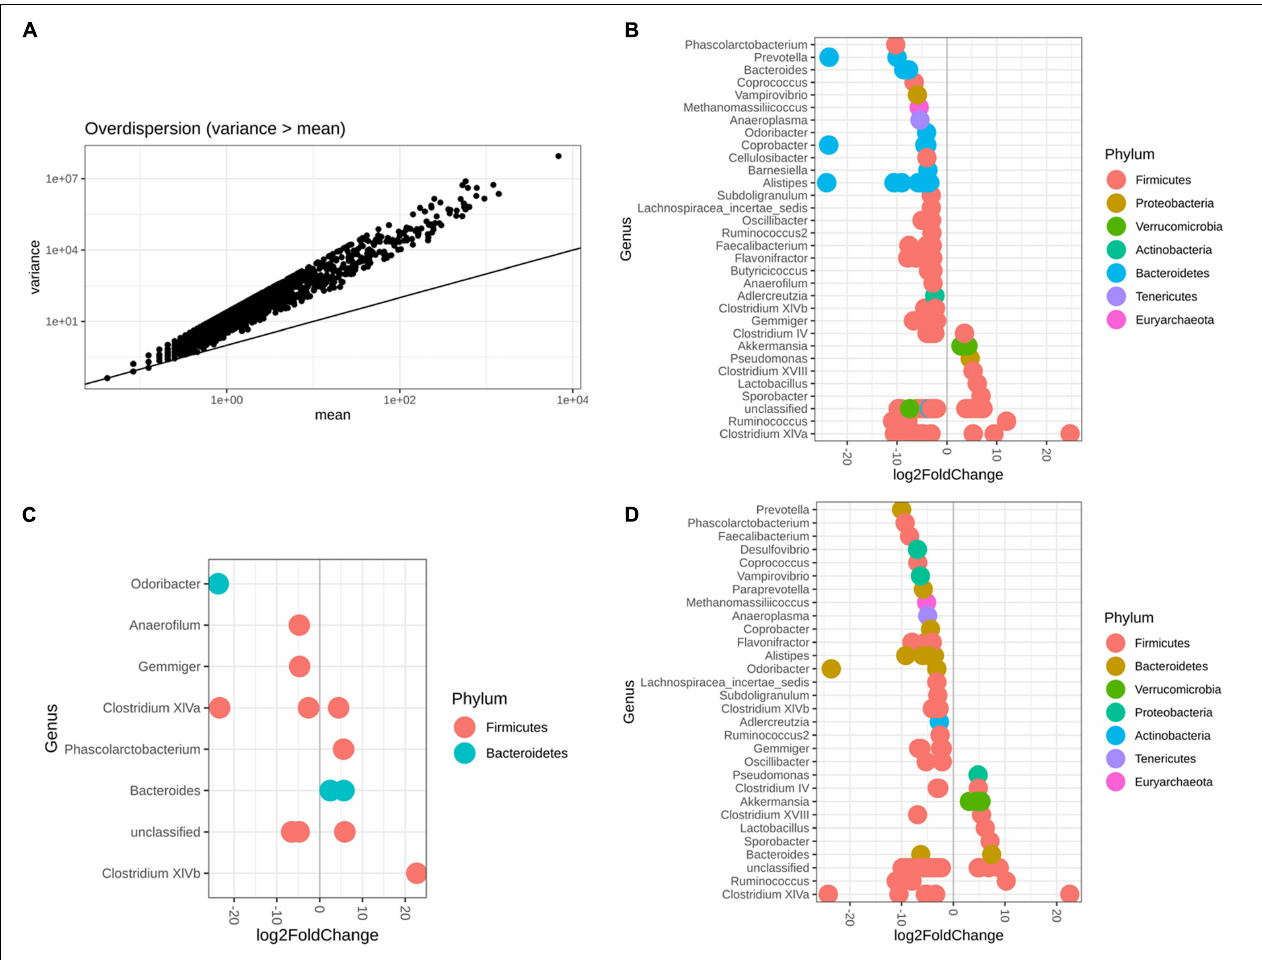
FIGURE 6 | DESeq2 bar plot showing the log2-fold-change of abundance at the Genus and Phylum level. The variance-mean dependence estimation (A) , and the OTUs altered in abundance with respect to both sex and diet (B) , sex (C) and diet (D) . log2FoldChange denotes relative differences in abundance between treatments, here log2FoldChange was greater than 2 or less than